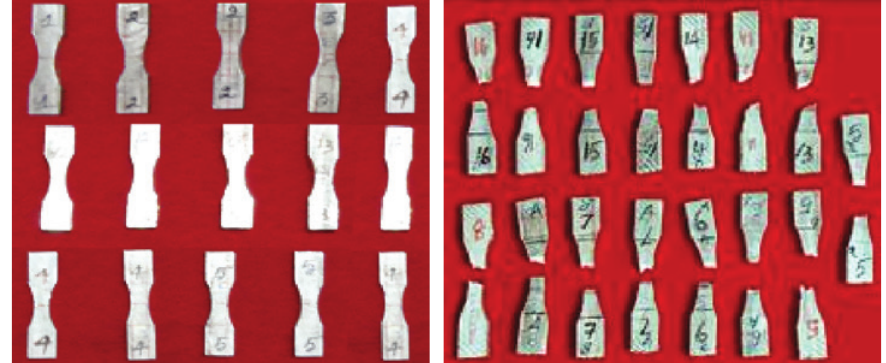
Figure 4: Photograph of tensile test specimen. (A) Before test and (B) after test.